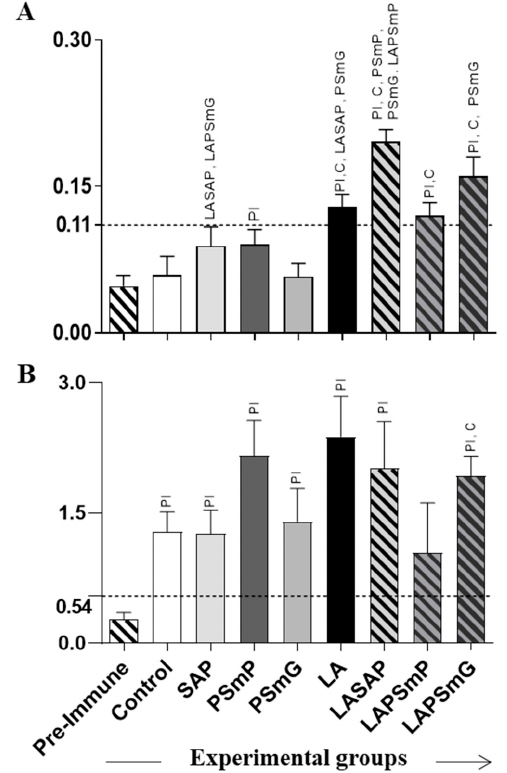
Figure 2. Anti- Leishmania infantum total IgG production. Hamster serum was obtained ( A ) 30 days after the third dose and ( B ) 180 days after the experimental challenge. The graphs represent the mean values and standard deviation of total IgG optical density measured by the ELISA assay for each group. The cut-off illustrated as a dotted line in the graph and used to assess the reactivity present in the samples is represented by the average of the absorbance values of the pre-immune serum sample added to the value of twice the standard deviation. The statistical difference ( p < 0.05) was represented by acronyms of the corresponding group. Legend: PI: pre-immune; C: control; SAP: saponin; PSmP: small empty submicron particle; PSmG: large empty submicron Particle; LA: L . amazonensis crude antigen; LASAP: L . amazonensis crude antigen associated with saponin; LAPSmP: small submicron particle associated with L . amazonensis ; LAPSmG: large submicron particle associated with L . amazonensis